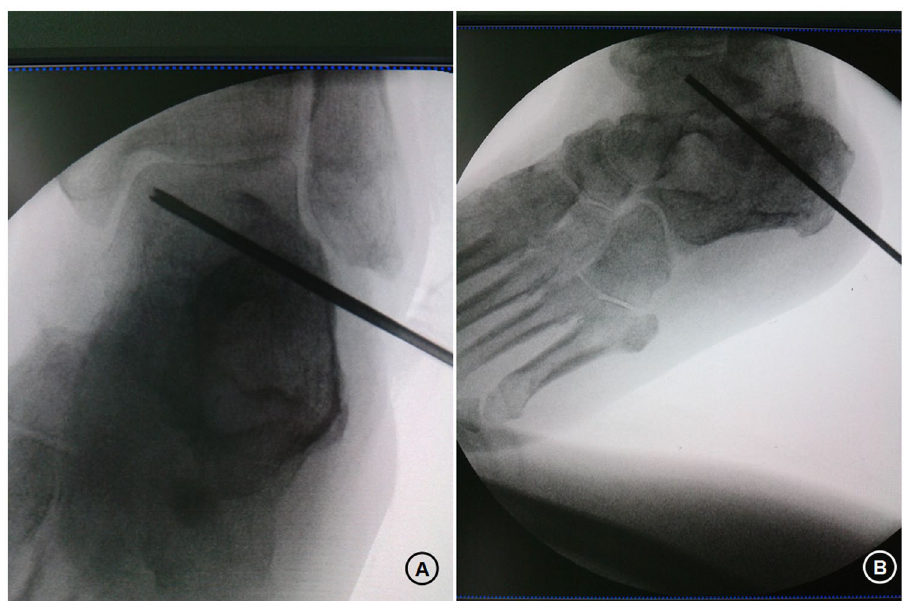
Figure 7. Fluoroscopy-guided positioning of the pilot Kirschner wire into the center of a medial osteochondral lesion (OCL) in AP and lateral plain view radiographs. Guided by the Kirschner wire, the hollow trephine was gently passed through the sclerotic zone of the osteochondral lesion (OCL), controlled by fluoroscopy in AP ( A ) and lateral ( B ) plain view radiographs. Debridement of the osteochondral lesion (OCL) through the drilling hole. The aspirate from the ilium could be injected under the guidance of the hollow trephine to the OCL site. Note: The patient consented to publish the specific